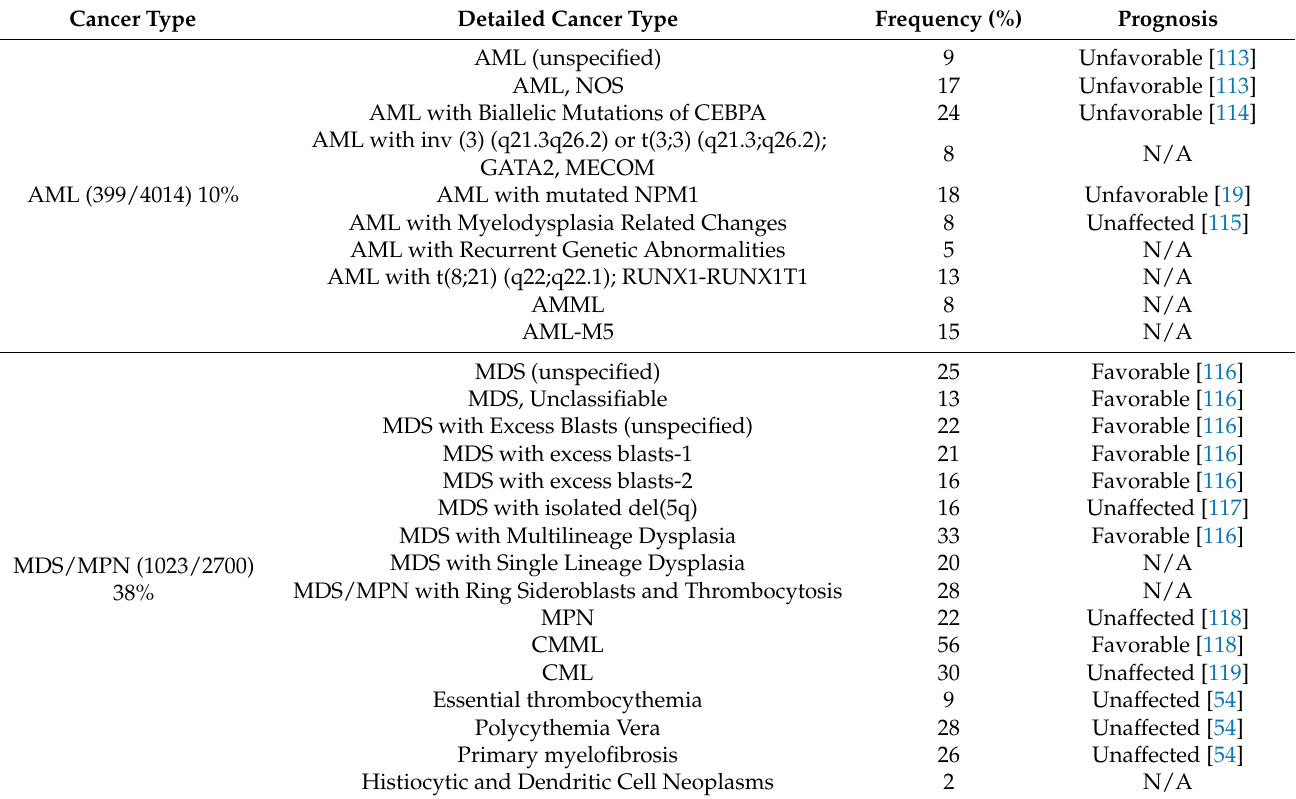
Table 1. List of TET2 mutation frequencies in hematologic malignancies and their prognos- tic value. Combined 12845 samples from 35 studies were analyzed according to cancer type and detailed classification based on WHO Classification of Hematologic Malignancies or The French–American–British (FAB) classification. Data from ‘Lymphoid’ and ‘Myeloid’ datasets from cBioPortal (https://www.cbioportal.org/, accessed on 19 January 2022) [45,46] and selected referenced studies [108,110–112]. AML = Acute myeloid leukemia, AMML = Acute Myelomonocytic Leukemia, AML-M5 = Acute Monoblastic/Monocytic Leukemia, CML = Chronic Myelogenous Leukemia, MPN = Myeloproliferative Neoplasms, MDS = Myelodysplastic Syndromes, CMML = Chronic Myelomonocytic Leukemia, CLL/SLL = Chronic Lymphocytic Leukemia/Small Lympho- cytic Lymphoma, DLBCL = Diffuse Large B-Cell Lymphoma, AITL = Angioimmunoblastic T-cell lymphoma, NOS = Not Otherwise Specified, N/A = Not Available. Detailed Cancer Type Frequency (%)